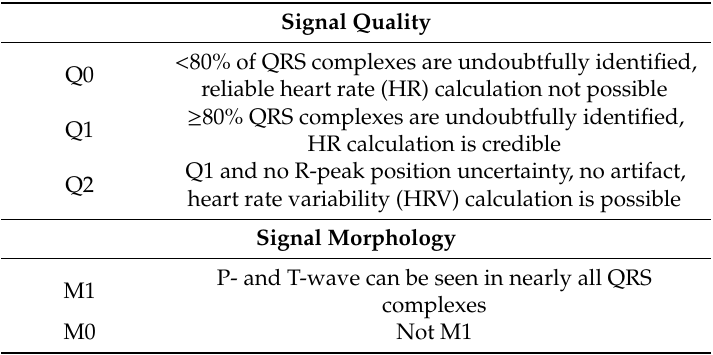
Table 2. ECG annotation conventions.